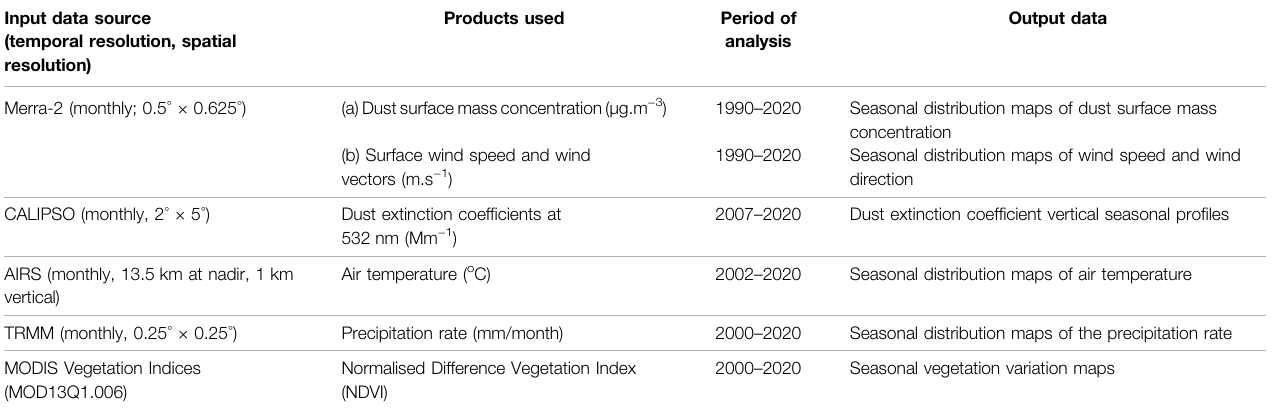
TABLE 1 | Summary of the data used in this